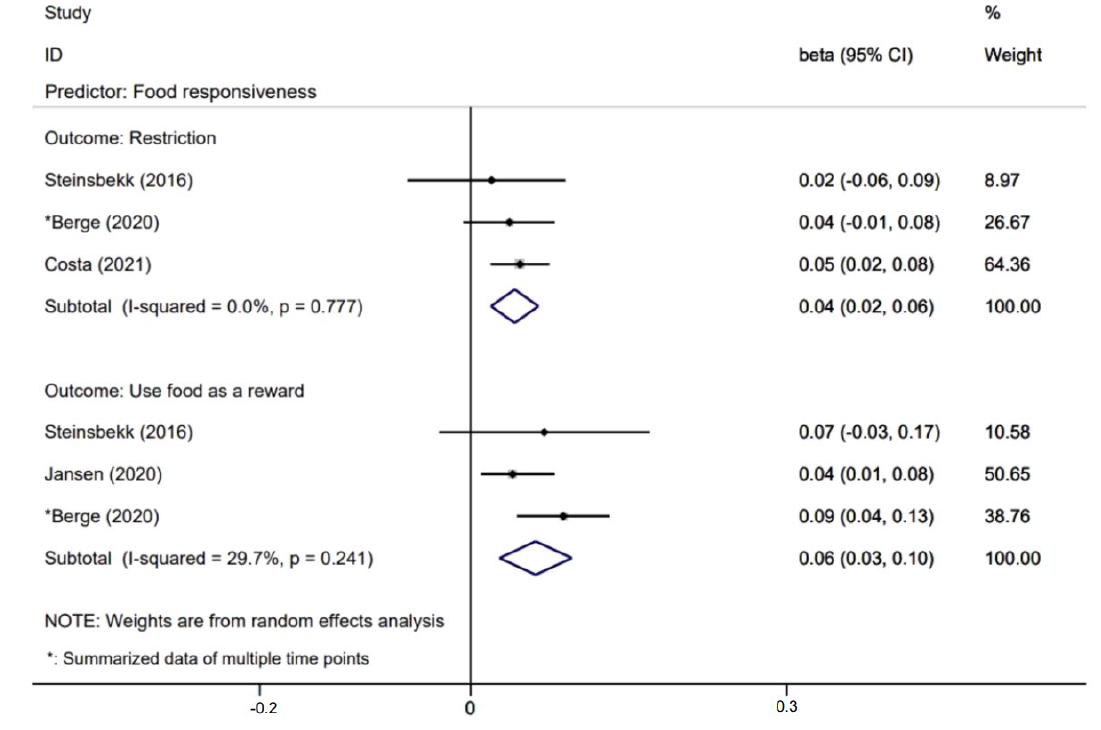
Figure 6. Effects of child food responsiveness on parental non-feeding practices.